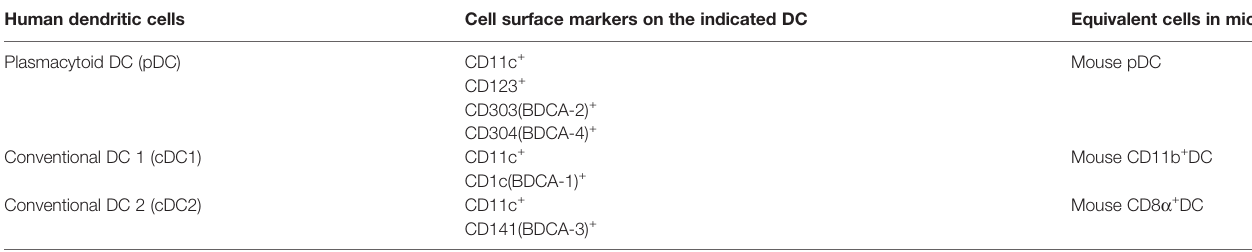
TABLE 1 | Three main subsets of dendritic cells in human peripheral blood under steady-state conditions. Human dendritic cells Cell surface markers on the indicated DC